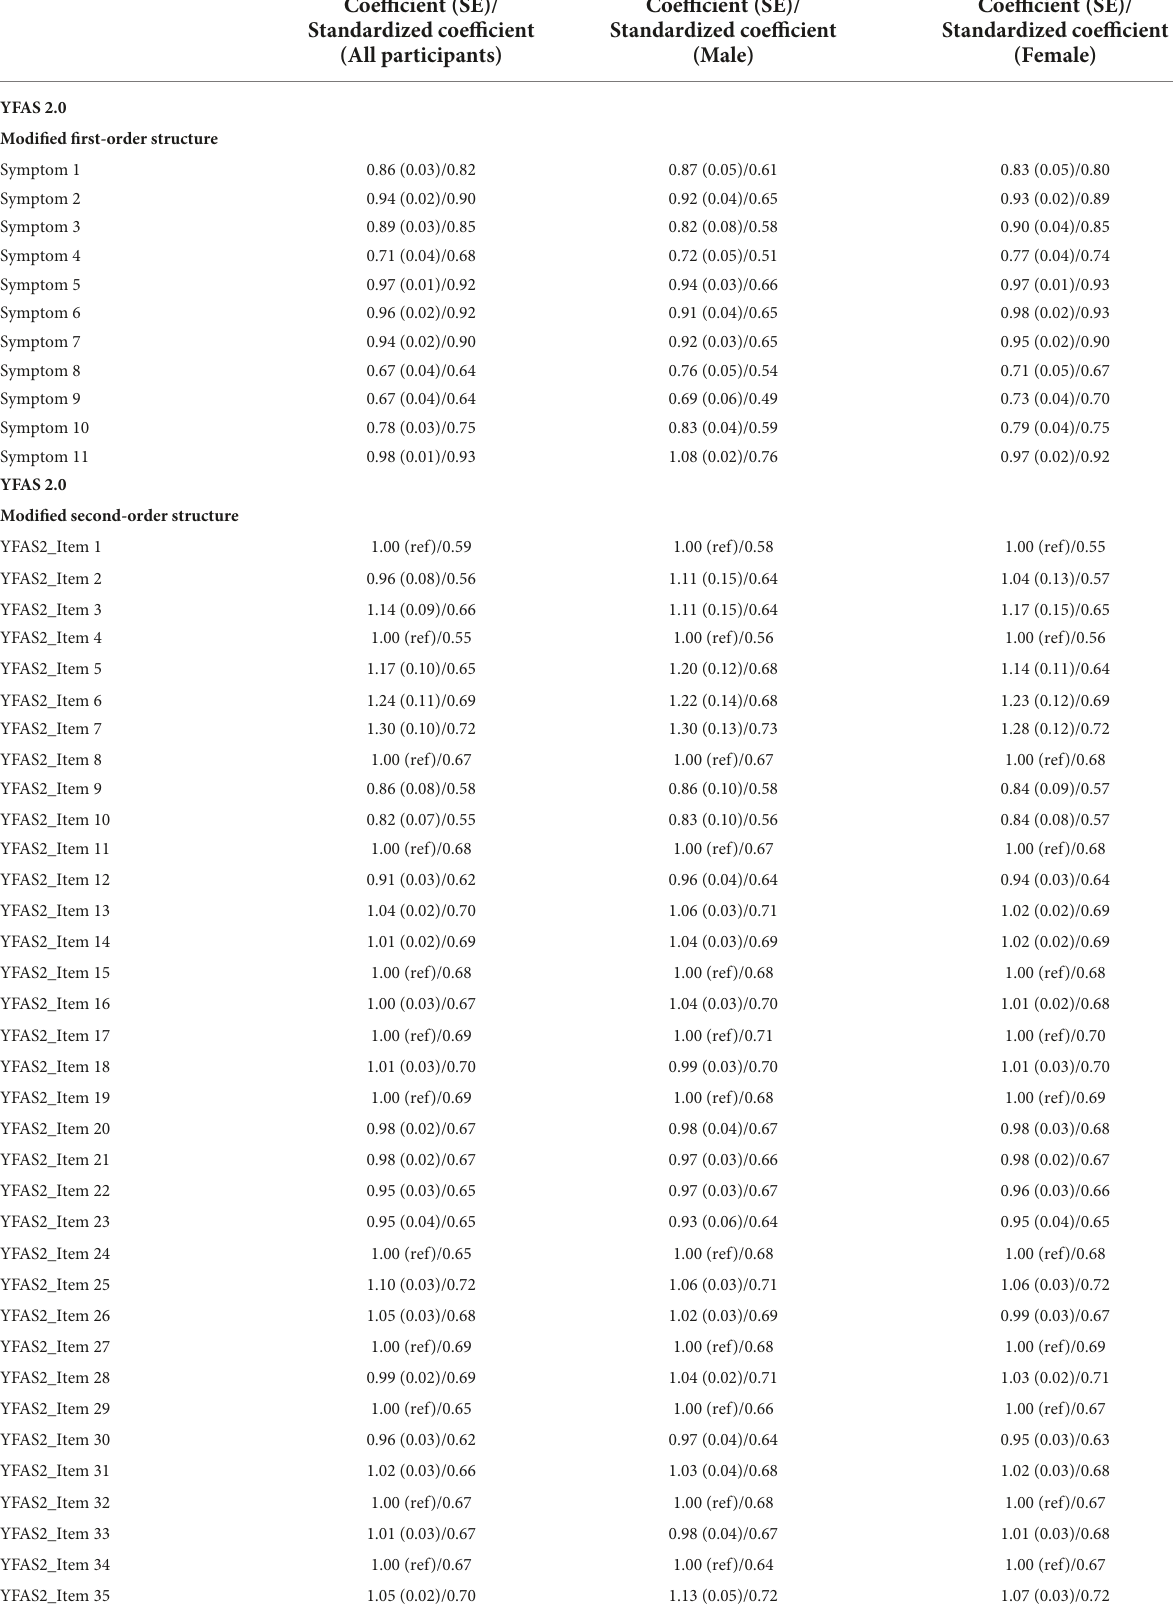
TABLE 3 Coefficients, standard error (SE), and standardized coefficients (aka factor loadings) of the final confirmatory factor analysis for the Yale Food Addiction Scale 2.0 (YFAS 2.0) and modified YFAS 2.0 (mYFAS